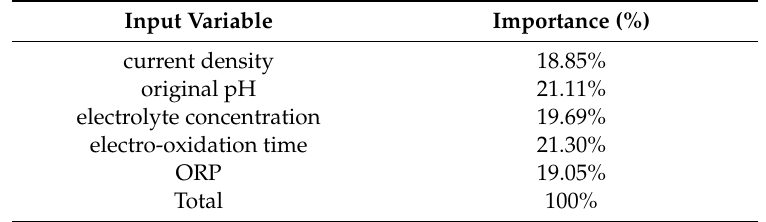
Table 6. Relative importance of input variables on the value of COD removal e ffi ciency and